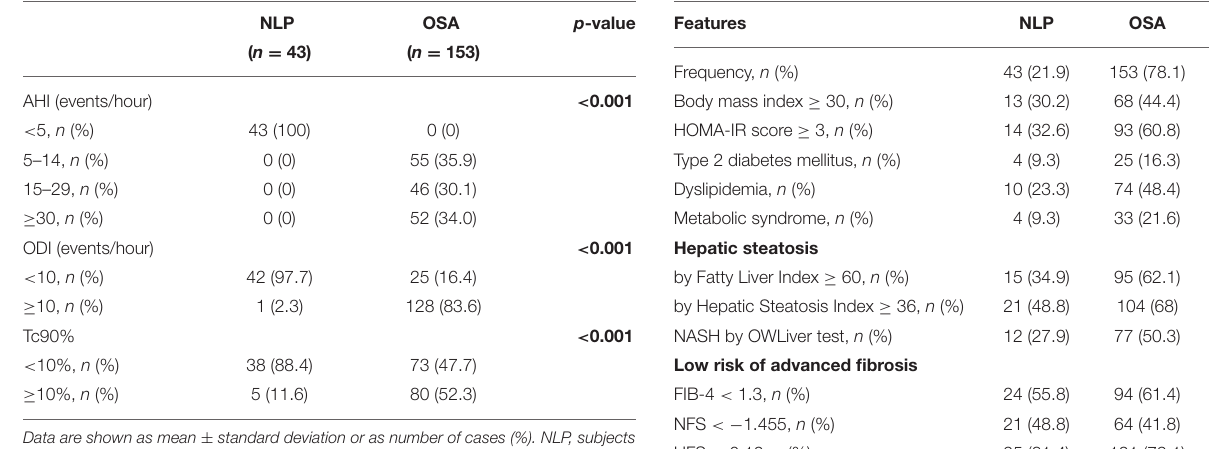
TABLE 2 | Polygraphic features of the study population. TABLE 3 | Metabolic and hepatic parameters of the study